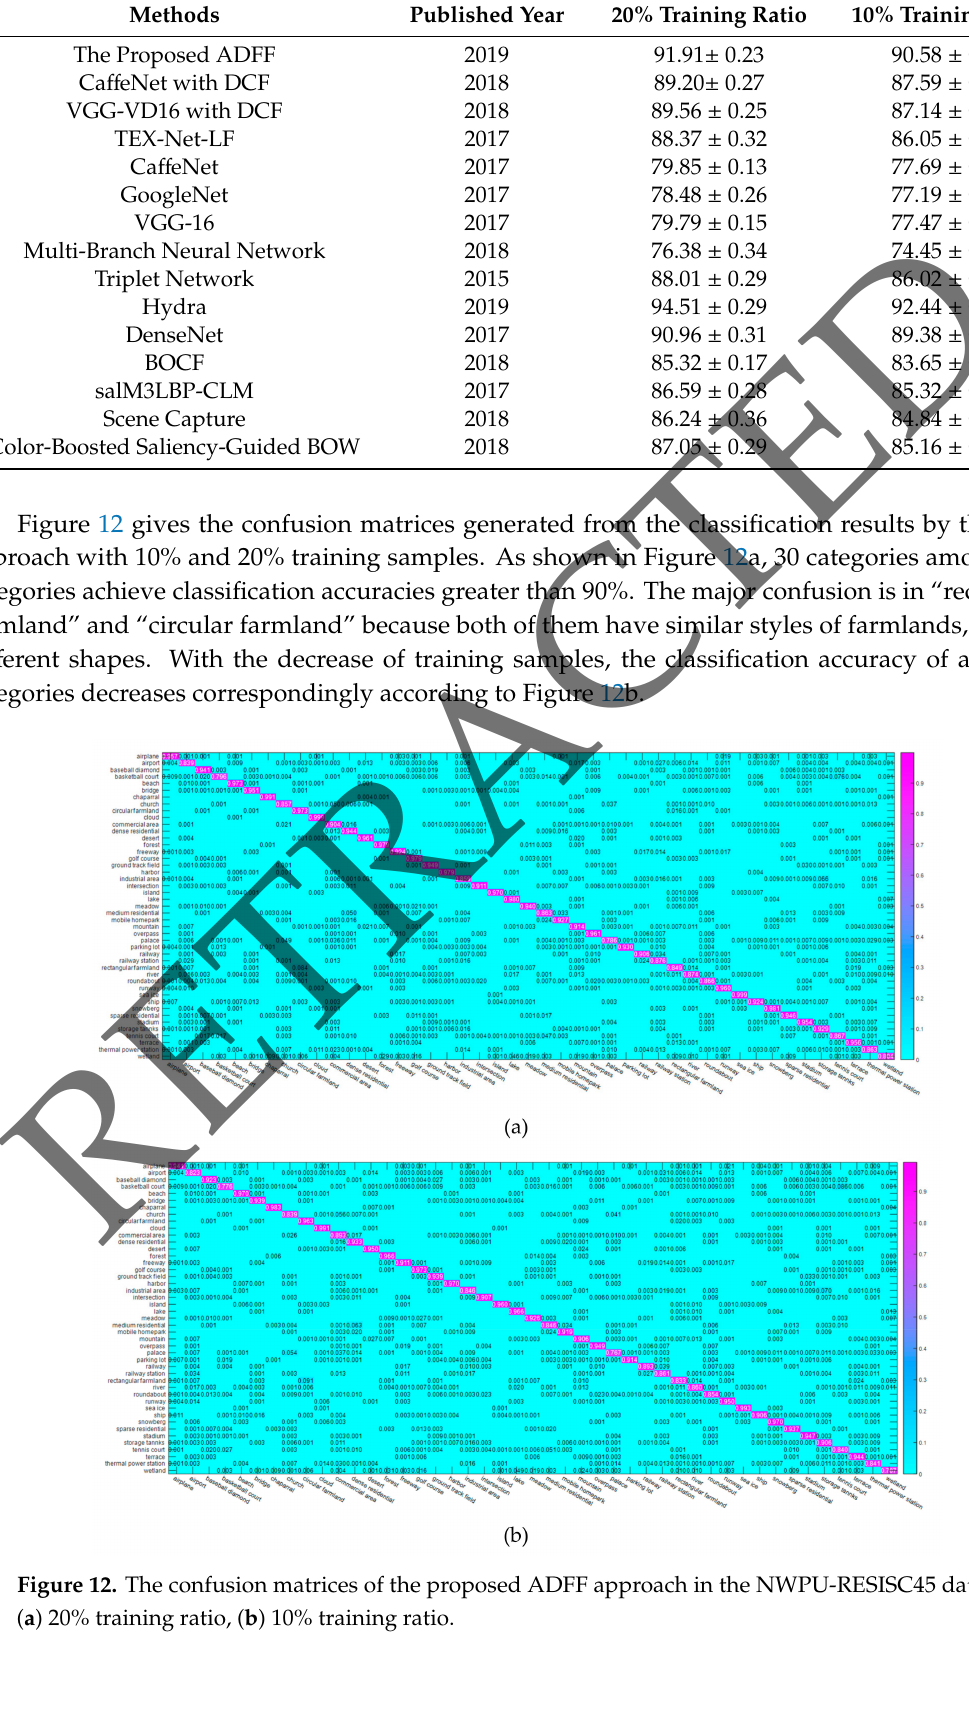
Table 4. Standard deviations and overall accuracy (%) of the ADFF framework and all baseline algorithms with 10% and 20% training ratio in the NWPU-RESISC45 dataset.